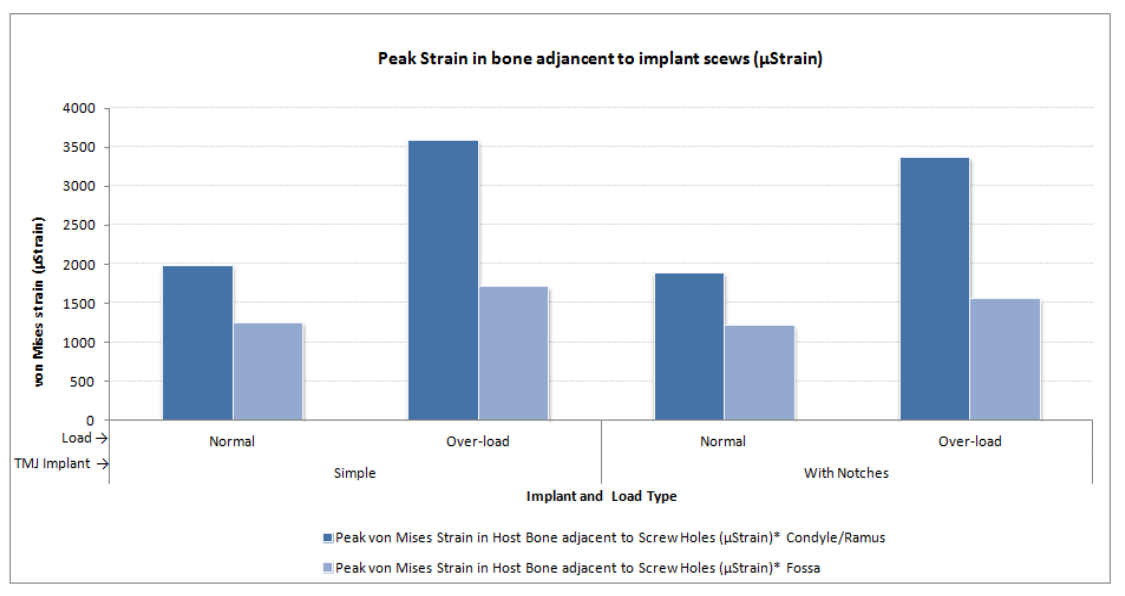
Figure 34. Peak micro-strain in the mandibular and fossa bone adjacent to fixation screws of total TMJ prostheses during FE simulations under normal and worst-case/over-load configurations.